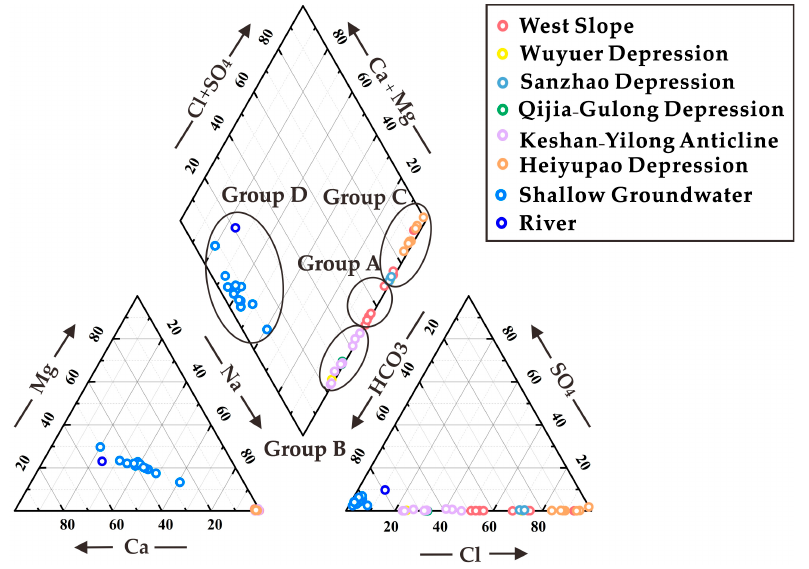
Figure 3. Piper diagram of all water samples.